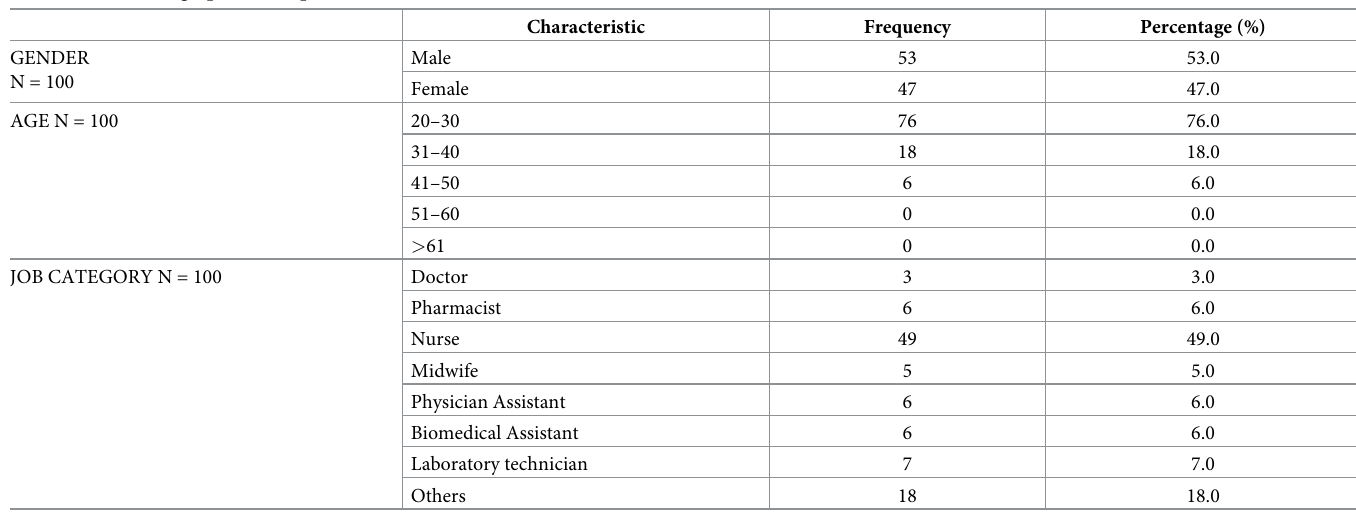
Table 3. Socio demographics of respondents (Health